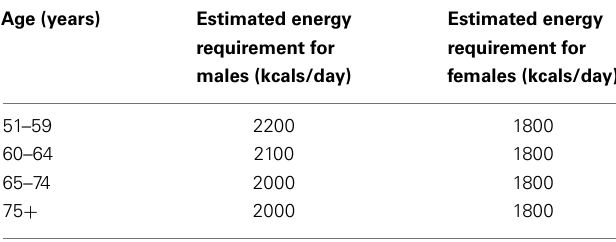
Table 1 | Estimated energy requirement (EER) according to